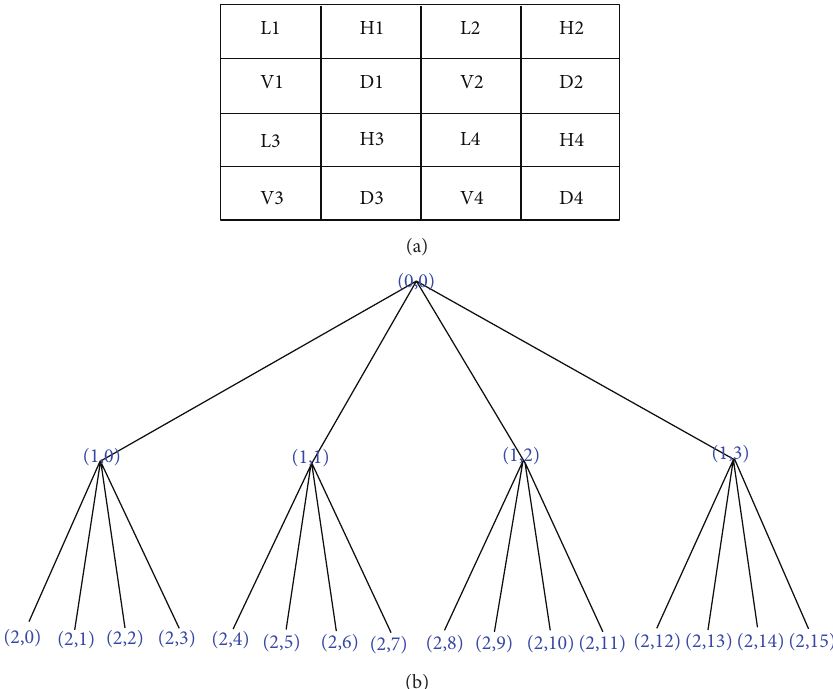
Figure 4: (a) Decomposition structure of wavelet packet transform at level two. (b) Wavelet packet decomposition tree up to level two.